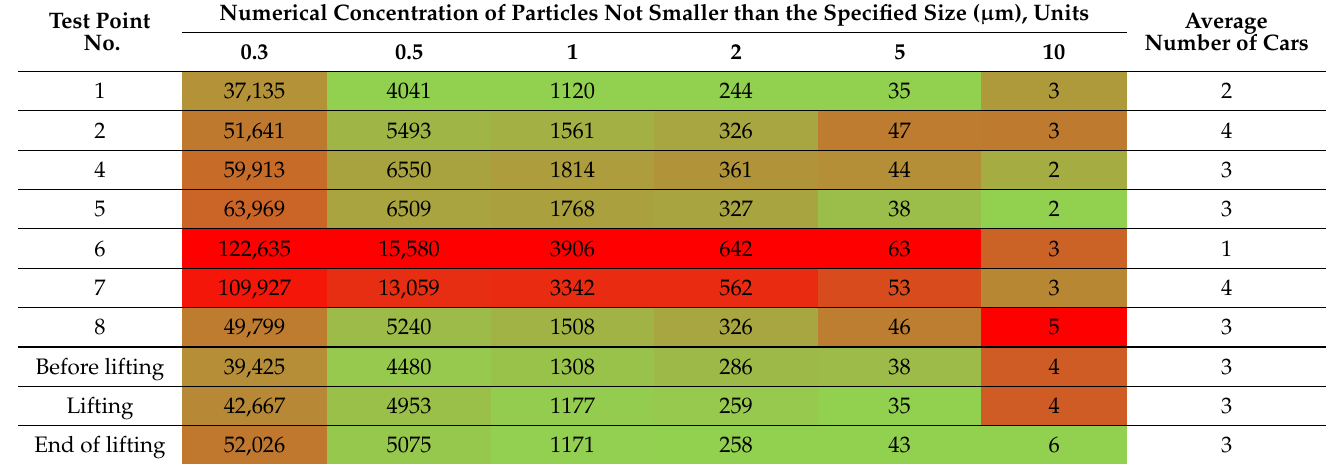
Table 6. Mean numerical concentrations of particulate matter at a height of 1.5 m in zone